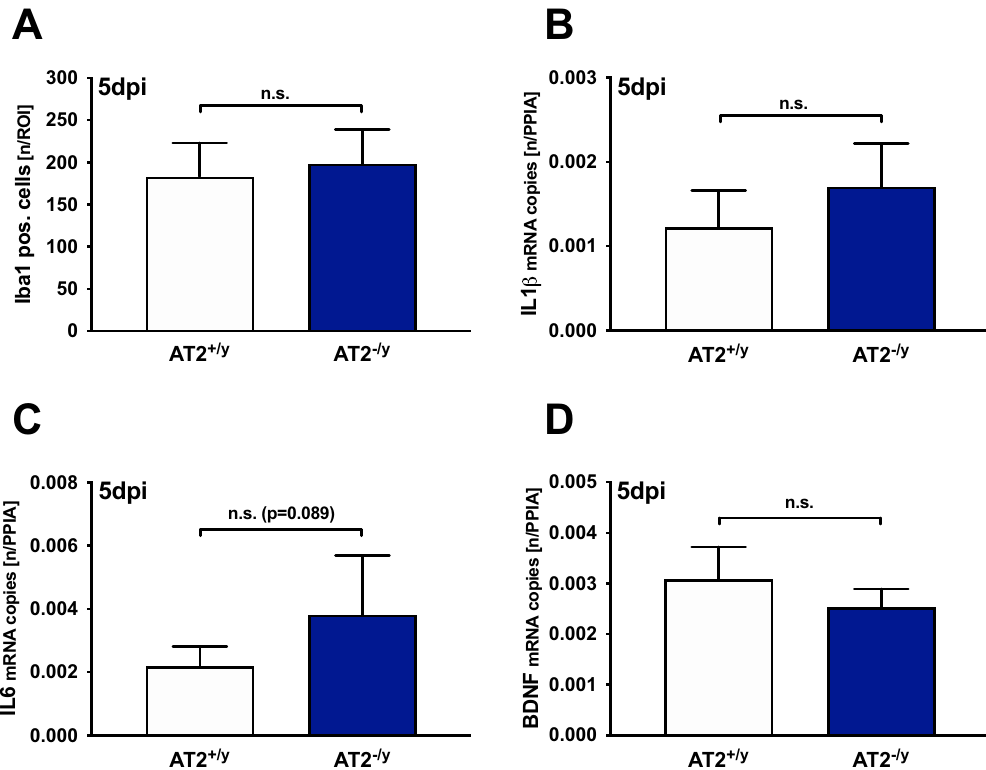
Figure 4. AT2 deficiency does not affect the neuroinflammation and neurotrophins: AT2-deficient mice (AT2 −/y ; n = 6; blue) were compared to age-matched WT mice (AT2 +/y ; n = 6; white) 5 days after TBI (5 dpi). Values are presented in mean ± SD; n.s. = not significant. ( A ) The number of Iba-1-immunolabelled activated microglia/macrophages 5 days after CCI in the perilesional region of interest (0.52 × 0.65 mm 2 ) was not different between the AT2 +/y and AT2 −/y groups. ( B ) , ( C ) , ( D ) The perilesional gene expressions of the cytokines IL1β and IL6 and of the neurotrophin BDNF, determined by qPCR, were not different between the AT2 +/y and AT2 −/y mice 5 days after TBI (5